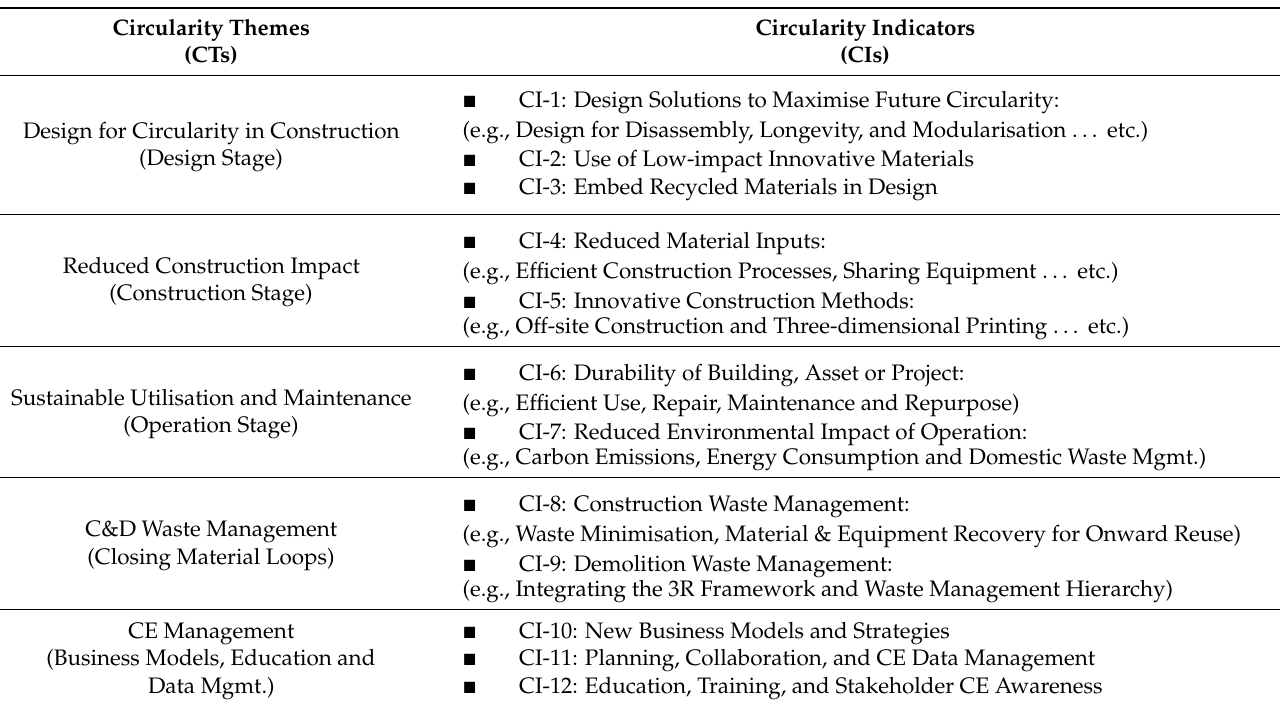
Table 2. PLACIT framework for circularity assessments (CAs) based on Abadi et al. Reprint with permission [23]; 2022, ICE